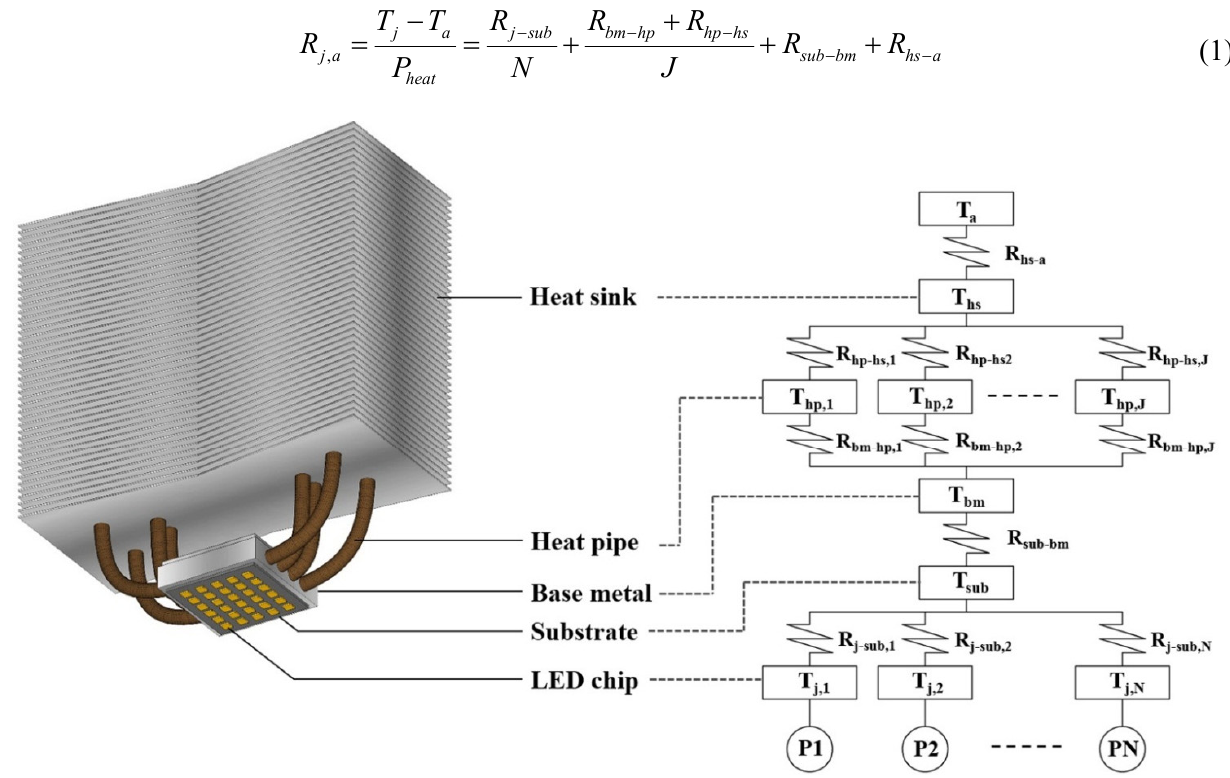
Figure 1. Illustration of LED lighting application and thermal network